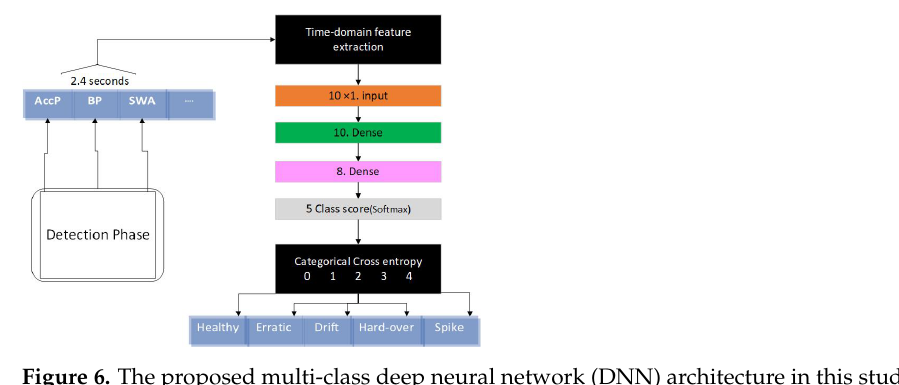
Figure 6. The proposed multi-class deep neural network (DNN) architecture in this study for fault isolation and